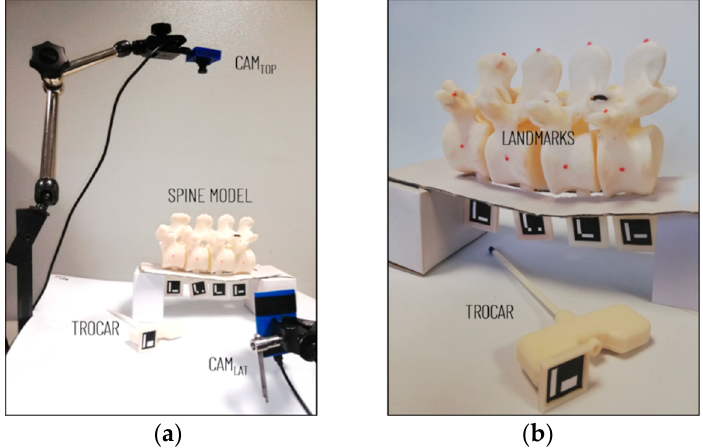
Figure 8. Testing setup: ( a , left ) configuration of the two cameras and the spine model; ( b , right ) a close-up of the spine model with 3D-printed spherical landmarks, and the trocar